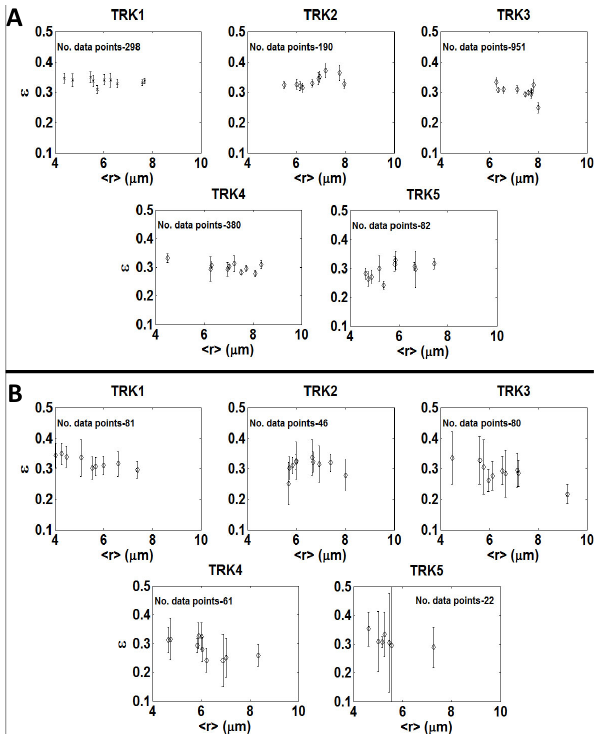
Figure 4. (a) Relative dispersion ( ε ) vs. height above the ground with colors representing the liquid water content (LWC) and (b) ε vs. LWC with colors representing the droplet concentration for the cloud boundary data points. Error bars represent the standard error of the average ε for each height level (in a ) and LWC (in b ) with a confidence level of 95%.